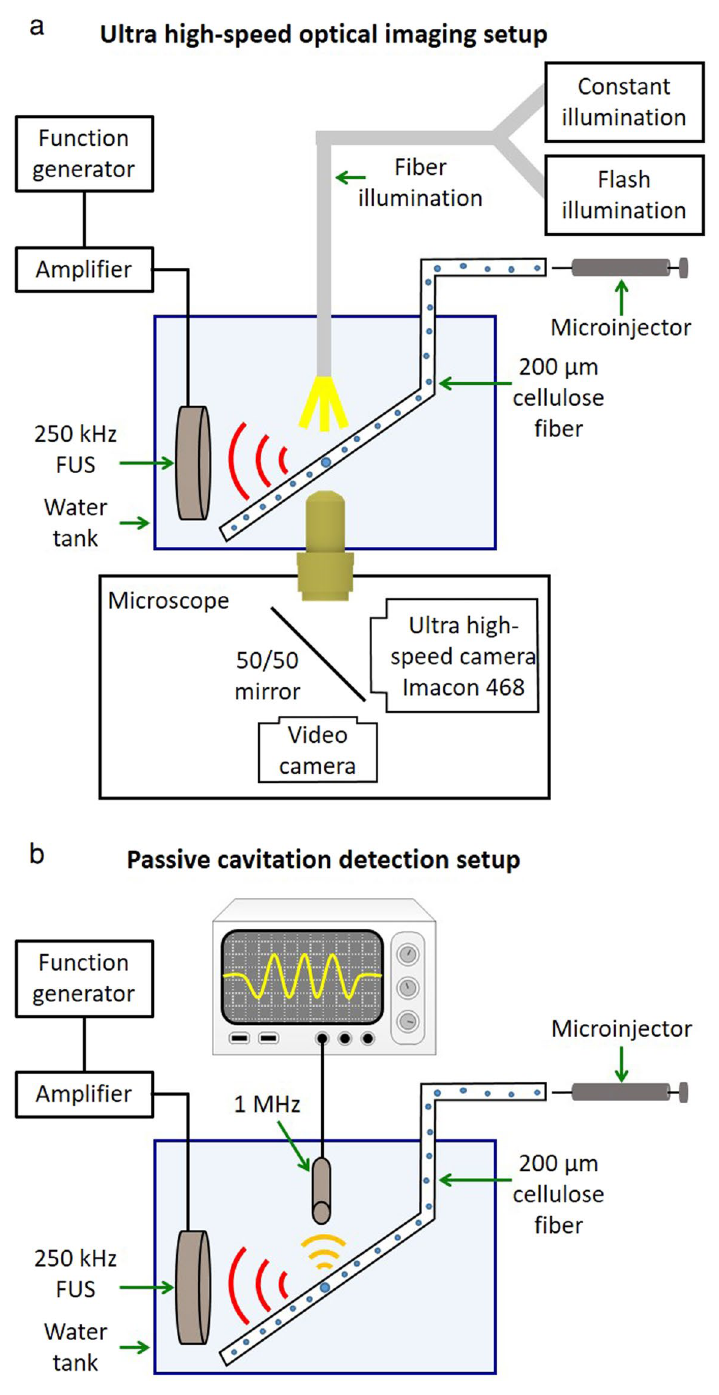
Figure 1. Experimental setups. ( a ) Ultra high-speed optical imaging setup. ( b ) Passive cavitation detection